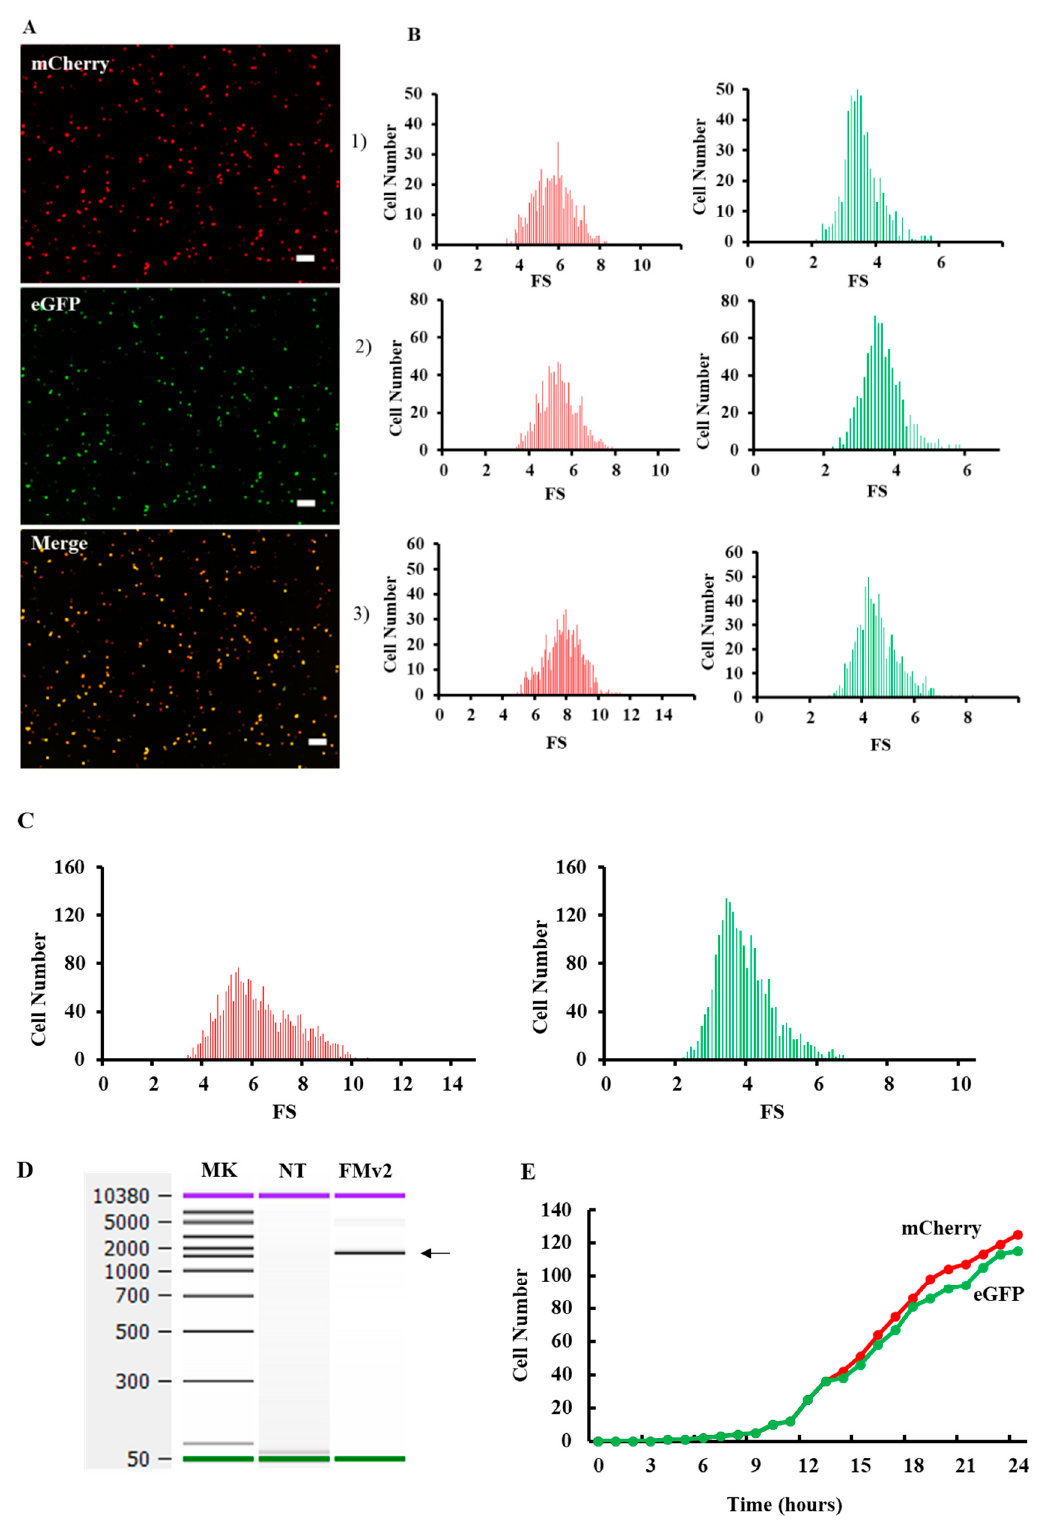
Figure 2. Fluorescence analysis of splicing product in the FMv2 transfected cells. ( A ) Fluorescence images of FMv2 transfected HeLa cells. The FMv2 transfected HeLa cells were scanned for fluorescence by a fluorescence microscope. Representative fluorescence images of HeLa cells are shown. Both red (mCherry) and green (eGFP) signals were clearly detected (top and middle, respectively). The merged figure of red- and green images (merge) produced yellow color (bottom). Scale bars: 100 µm. ( B ) Histograms of fluorescence positive cells. By scanning three wells for each fluorescence, the fluorescence intensity of each cell was obtained. Then, the fluorescence strength (FS)